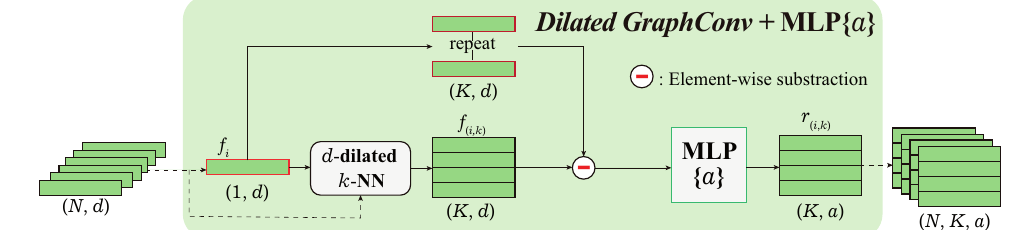
Figure 7. Dilated Graph Convolution. N points are input and K relative features of each point are